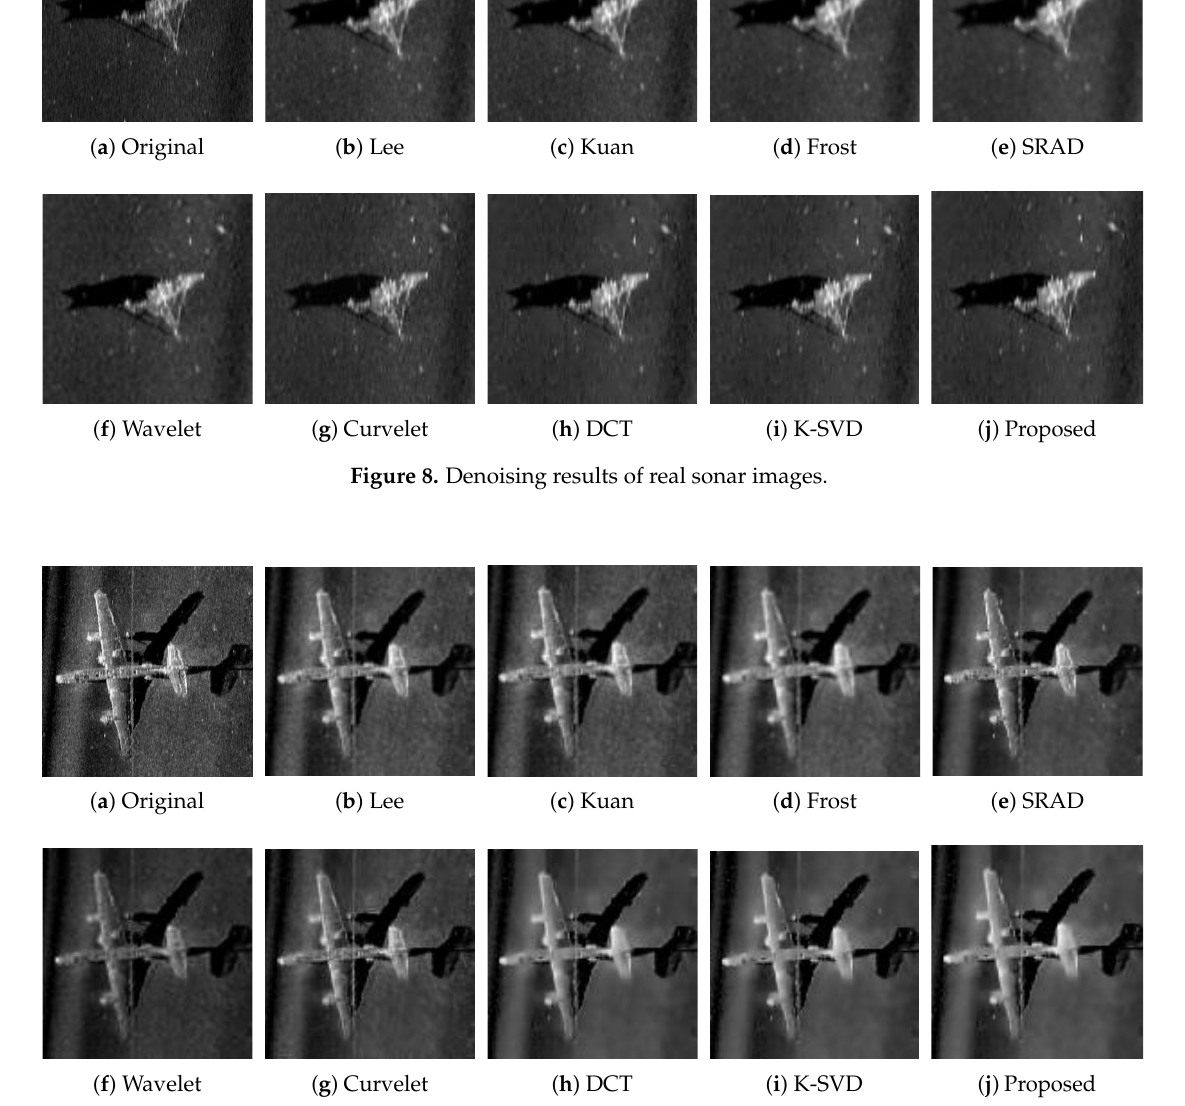
Figure 9. Denoising results of real sonar